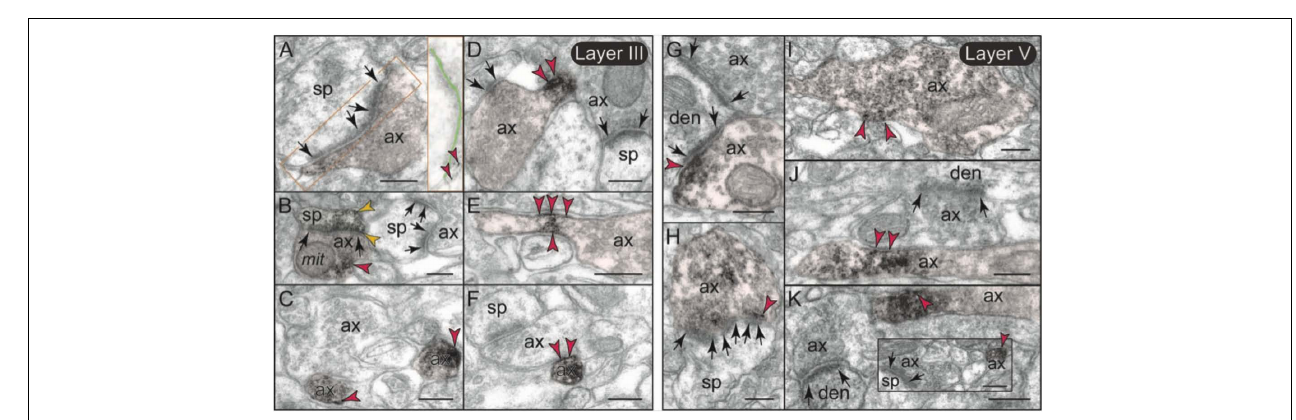
FIGURE 8 | Presynaptic expression of mGlu3 in layers II/III and V of rat PFC. (A,B) In layer II/III, a moderate presynaptic component of mGlu3 is captured in glutamatergic-like axons terminals establishing asymmetric synapses both near the synaptic active zone (A) , and extrasynaptically near a mitochondrion (B) . One of the two spines in (B) is also labeled. The synaptic cleft is magnified and highlighted with light green shading in (A) to better show the location of mGlu3 labeling in relationship to the synapse. (C–F) Bundled preterminal axons typically express mGlu3 at the plasma membrane. (G–K) In layer V, presynaptic mGlu3 can be visualized perisynaptically on membranes flanking the synapse (G,H) , and near presynaptic vesicles (G–I) , with an additional component in preterminal axons (J,K) . Preterminal axons are shown both in cross-section (e.g., C ), and in longitudinal section (e.g., D ) for comparison. Synapses are between arrows. Red arrowheads point to mGlu3 immunoreactivity on axons; yellow arrowheads in (B) indicate additional mGlu3 labeling on a spine. Profiles are pseudocolored for clarity. as, astrocyte; ax, axon; den, dendrite; mit, mitochondrion; sp, spine. Scale bar: 200